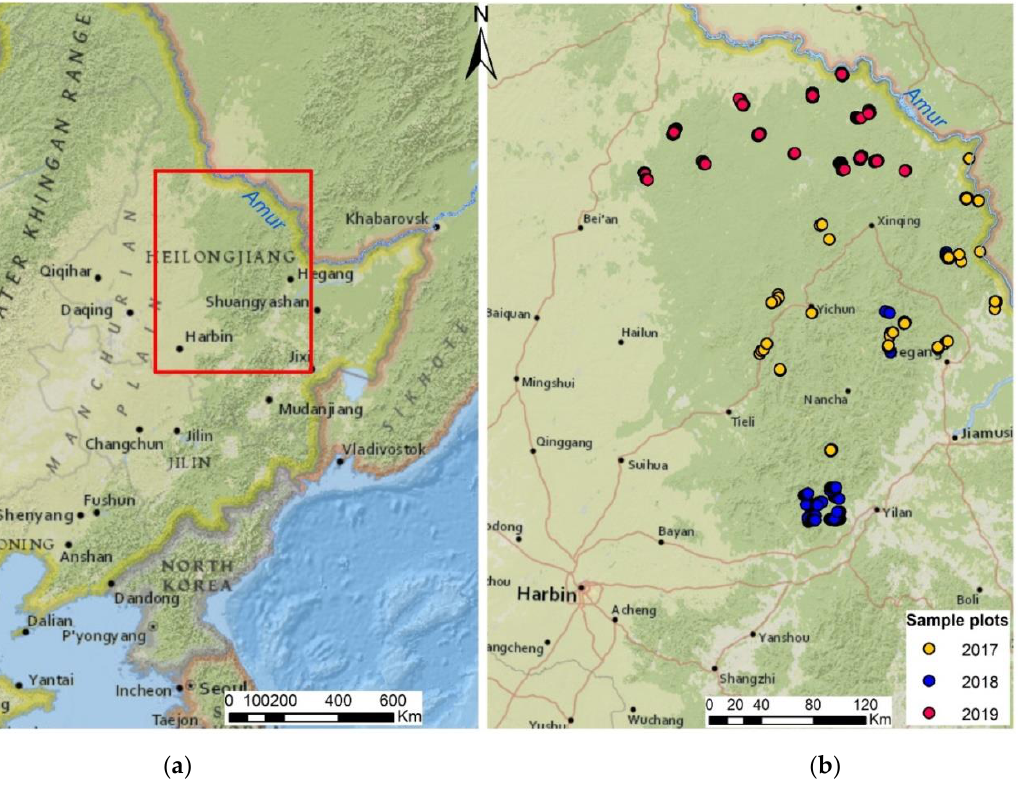
Figure 1. ( a ) Map of the study area. The Lesser Khingan mountain system is located in the north central part of Heilongjiang Province, China and borders Russia in the northeast, rectangle – study area; ( b ) map indicating field collection sites.